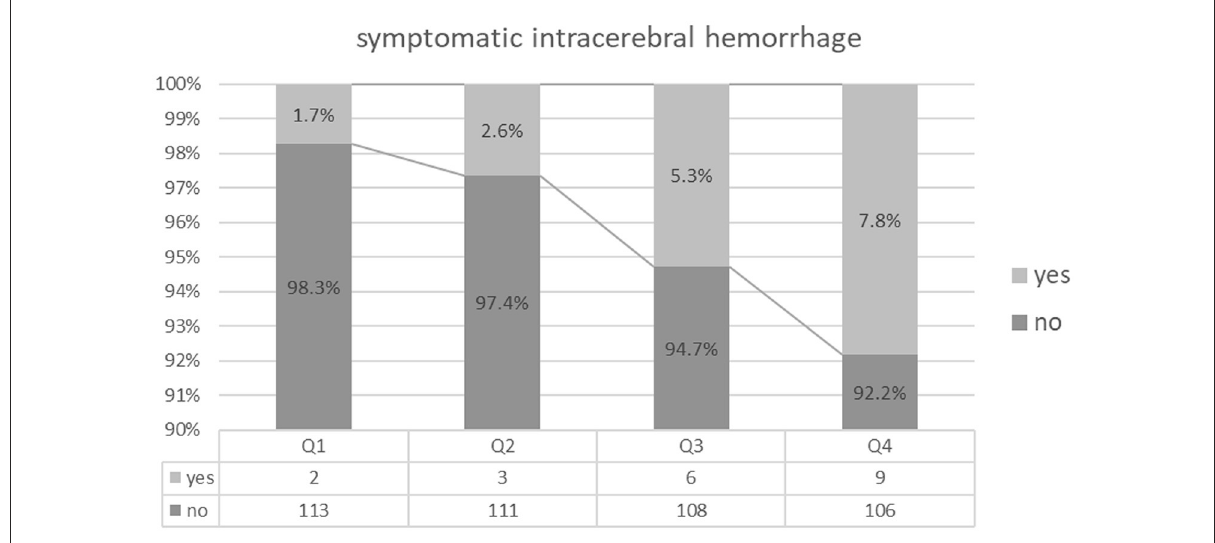
FIGURE4 Symptomatic intracerebral hemorrhage comparison among the quartile groups.